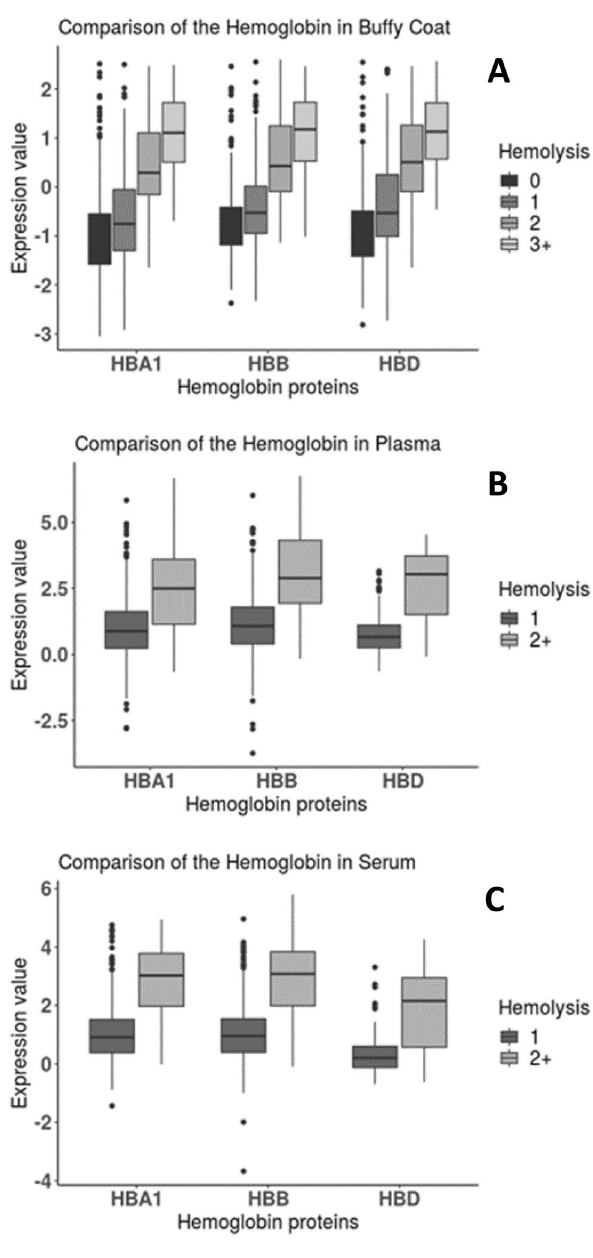
Figure 5. Expression of hemoglobin proteins in ( A ) buffy coat, ( B ) plasma, and ( C ) serum (HBA1 = Hemoglobin Subunit Alpha, HBB = Hemoglobin Subunit Beta, HBD = Hemoglobin Subunit Delta) as a relative measure of hemolysis. ( A ) HBA1 protein expression comparison between hemolysis score of 0 versus 1 in buffy coat with adjusted p value of 0.0014, comparison between 0 versus 2 with adjusted p value of 1.29e −38 and comparison between 0 versus 3 with adjusted p value of 2.29e −47 . HBD protein comparison between 0 versus 1 with adjusted p value of 1.40E −05 , comparison of 0 versus 2 with adjusted p value of 6.23e −44 and comparison of 0 versus 3 with adjusted p value of 7.28E −49 . HBB protein comparison between 0 versus 1 with adjusted p value of 0.0005, comparison of 0 versus 2 with adjusted p value of 1.13e −40 and comparison of 0 versus 3 with an adjusted p value of 2.62e −47 . Samples were grouped into hemolysis score 1 and 2+ for plasma and serum due to low number of score 3 and 4 samples in these matrices. ( B ) For plasma shows HBA1 protein comparison of hemolysis score 1 versus 2 with adjusted p value of 6.65E −09 , HBB protein comparison 1 versus 2 with adjusted p value of 4.24e −10 , and HBD protein comparison of 1 versus 2 with adjusted p value of 0.00027. C For serum shows HBA1 protein comparison 1 versus 2 with adjusted p value of 4.16e −22 , HBB protein comparison 1 versus 2 with adjusted p value of 1.15e −23 , and HBD protein comparison of 1 versus 2 with adjusted p value of 3.56e −09